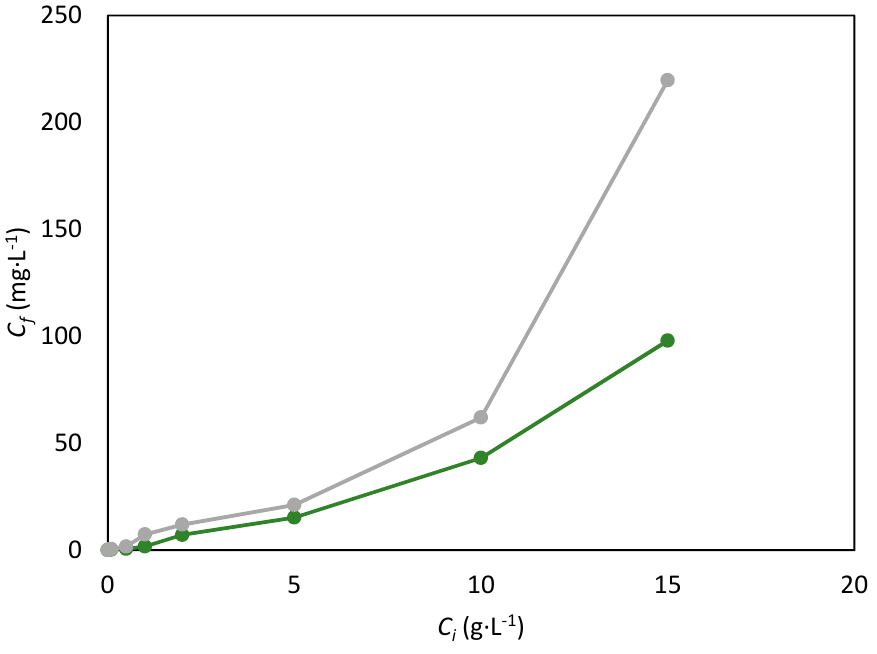
Figure 1. Extraction efficiency ( E %) versus initial concentration ( C ) of phenol ▬ , o-cresol ▬ and 2-chlorophenol ▬ for the extraction using [EMim][DCA] and [EMim] [DCA] (